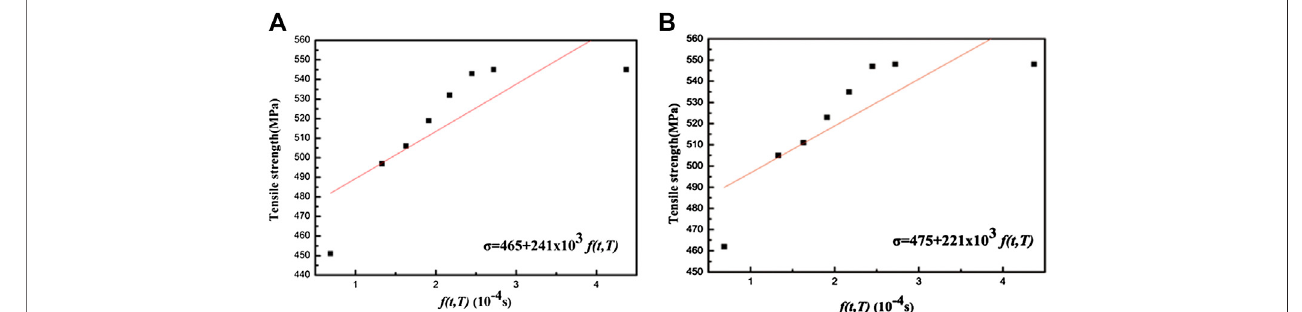
FIGURE8| Relationshipbetweentensilestrengthand f(t,T) ofsinteredFe-2Cu-0.8C-0.6Mo-2Wmaterialsfromdifferentpowdermixtures. (A) ELpowdermixtures; (B) PD powder mixtures